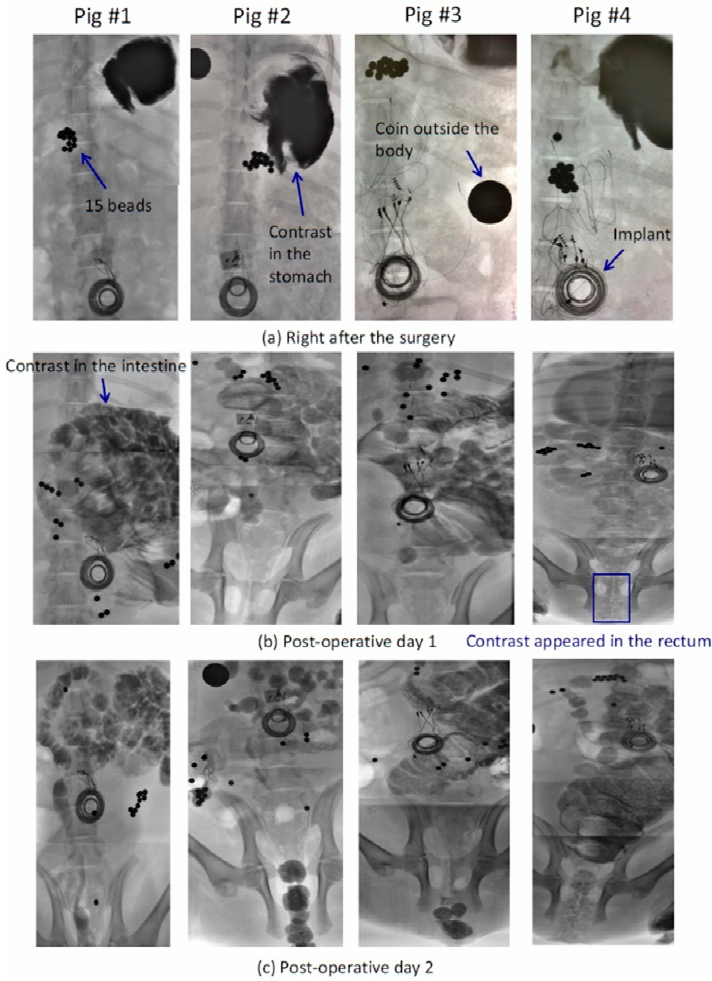
Figure 9. Intestinal transit examined through X-ray photography. Pigs 1 and 2 are control group, while 3 and 4 are the experimental group. ( a ) Fifteen metal beads were inside the intestine, and X-ray contrast was in the pigs’ stomach right after the surgery. ( b ) On postoperative Day 1, the contrast appeared in the rectum in Pig 4 with electrical stimulation, while the contrast had only moved to the intestines in other pigs, suggesting that electrical stimulation likely facilitates intestinal transit. Defecation of feces was also observable in Pig 4 but not in other pigs. ( c ) Contrast moved to the rectum in all pigs on postoperative Day 2. Note that each image is combined with photos taken by the camera as the X-ray machine does not support an image-capture function, and its field of view is not broad enough to show the whole GI tract on the screen.